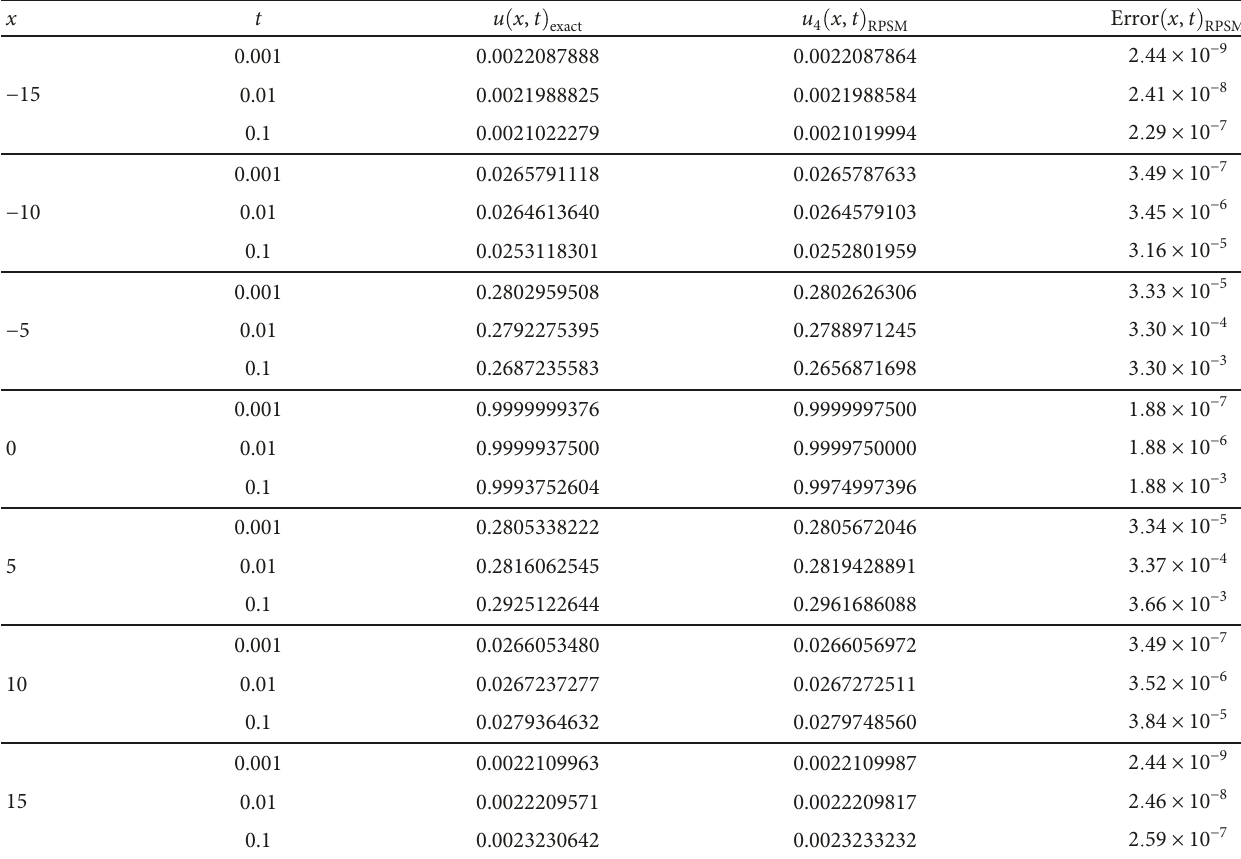
Table 1: Solutions for α = 1 .